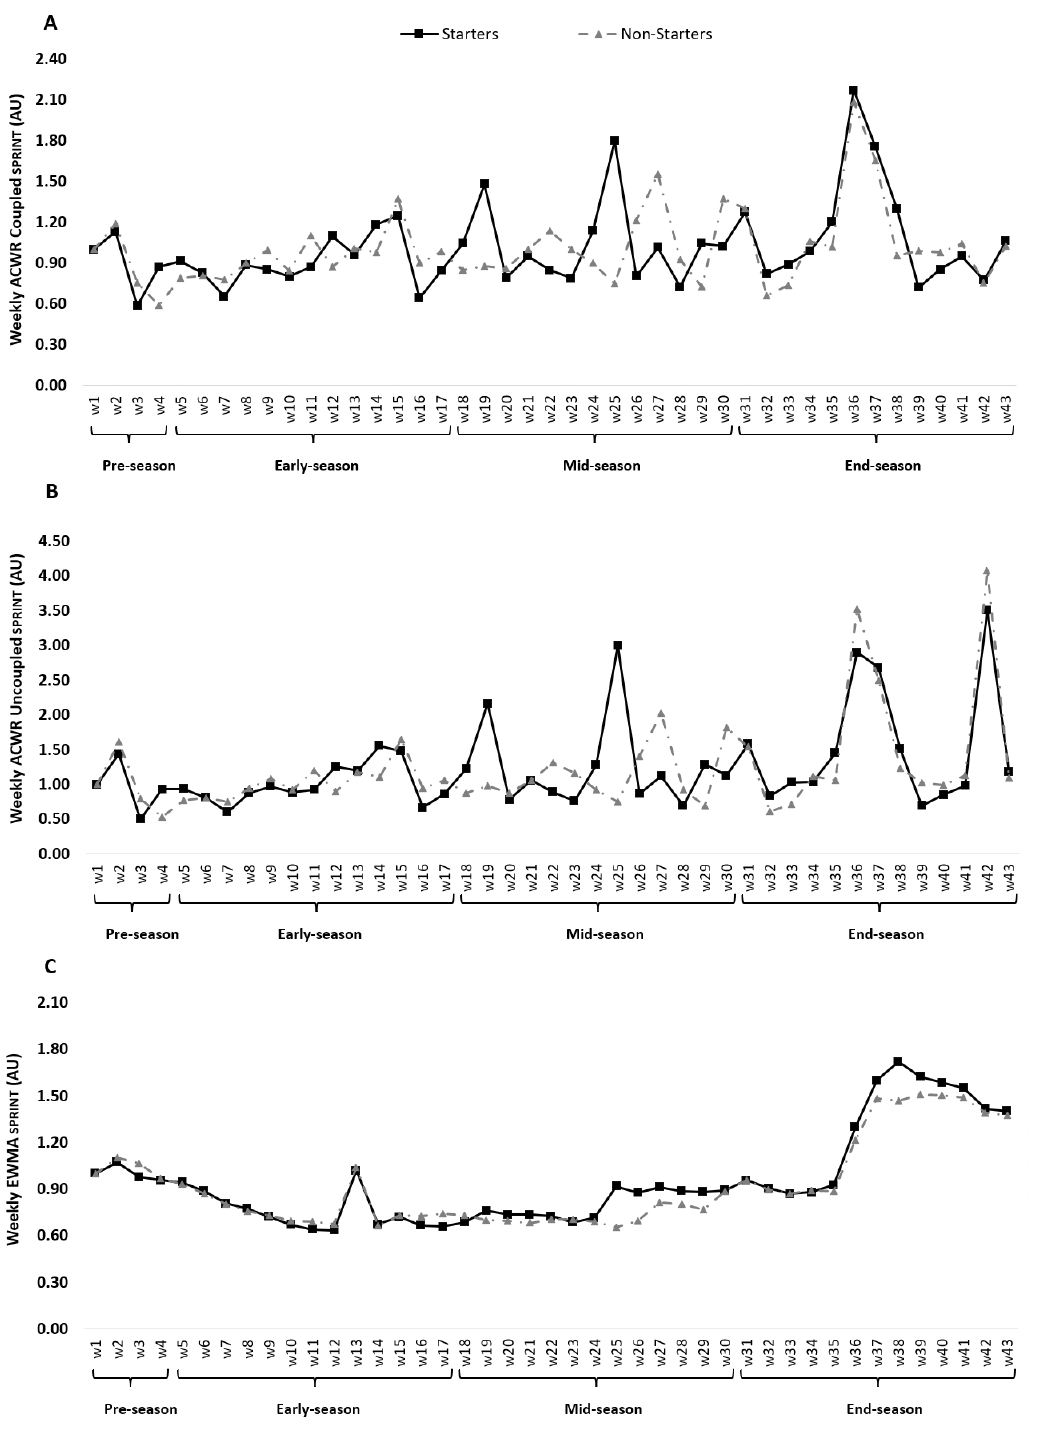
Fig. 2. ACWR coupled (A), ACWR uncoupled (B), and EWMA (C) variations calculated based on sprint distance across 43 weeks for starters and